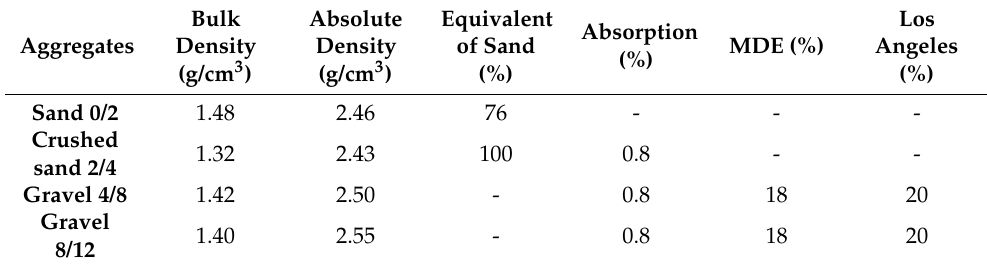
Table 4. Physical parameters of aggregates.